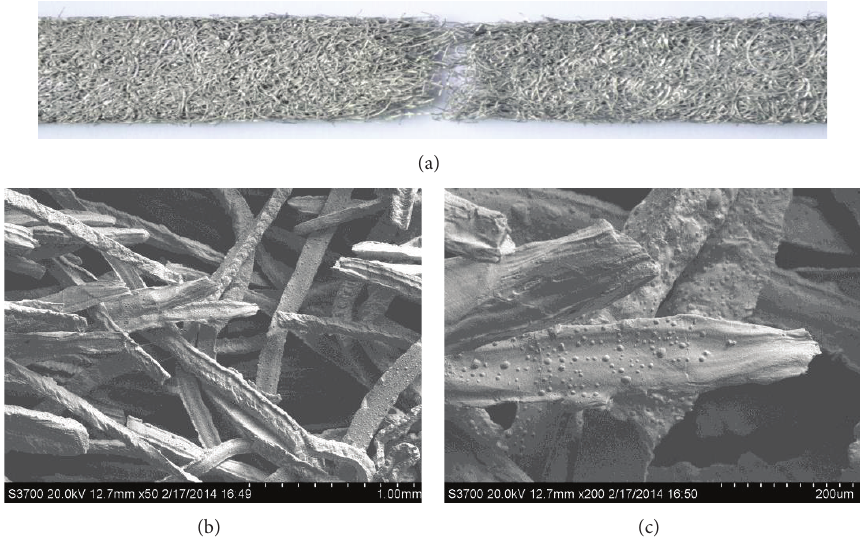
Figure 9: Failed sample with 75% porosity sintered at 1200 ∘ C for 60min after tension test. (a) Fracture appearance, (b) SEM image of fracture region, and (c) fractured fiber with necking section.